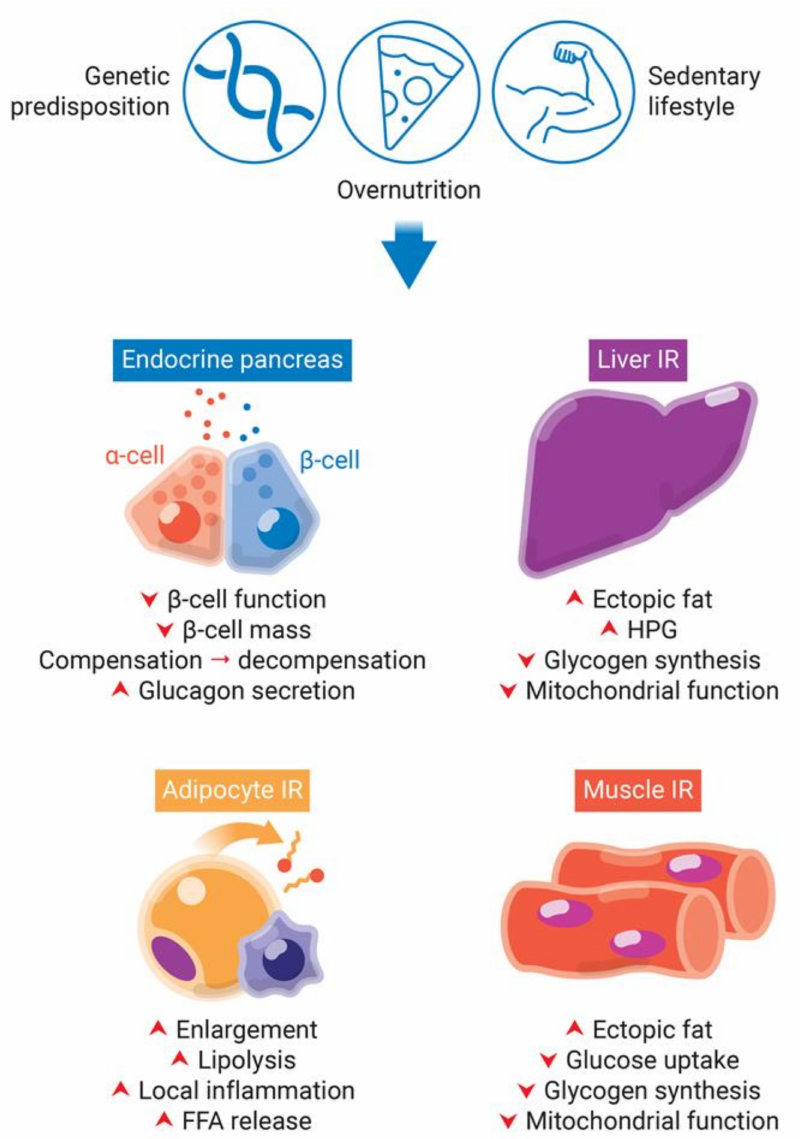
Figure 2. Obesity-induced pancreatic β -cells dysfunction and insulin resistance (IR) in peripheral tissues. Genetic predisposition, overnutrition, and a sedentary lifestyle are involved in obesity and type 2 diabetes development. The lipotoxicity involved in chronic obesity and hyperglycemia leads to an increase of insulin demand due to IR in peripheral tissues. While in a first moment, β -cells try to compensate for IR by increasing insulin synthesis, they start to decompensate in late stages, with decrease of β -cell function and mass. IR in adipocytes eliminate insulin-induced repression of lipolysis. Impaired adipogenesis and dysfunctional hypertrophy of adipocytes increase plasma levels of free fatty acids (FFAs). Additionally, dysfunctional adipose tissue releases increased levels of insulin resistance-inducing pro-inflammatory adipokines, leading to local inflammation. The increased FFAs flux to the liver and skeletal muscle leads to increase of fat deposition, decrease of glycogen synthesis and mitochondrial dysfunction. Additionally, the hallmark of insulin resistance in the liver is increased hepatic glucose production